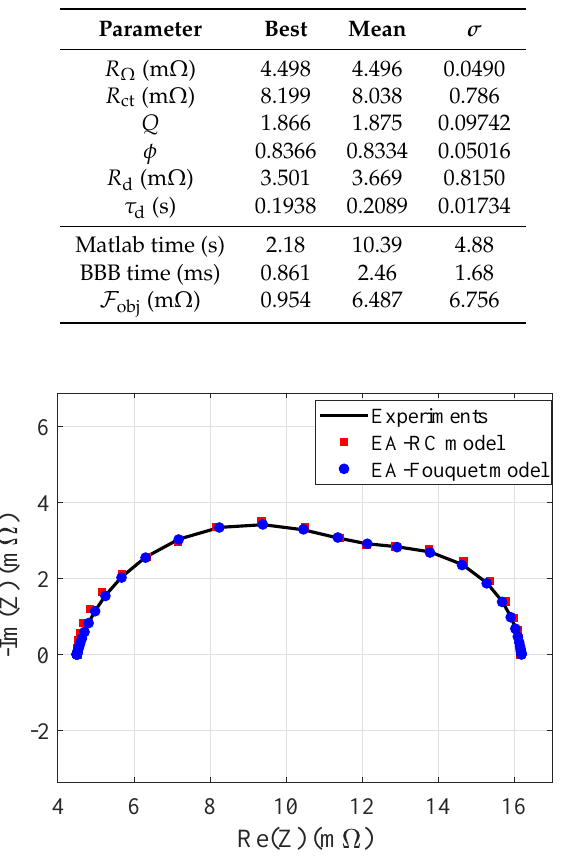
Figure 4. Fouquet experimental data [14]. Results achieved by the evolutionary algorithm (EA) in the identification of resistive-capacitive (RC) and Fouquet